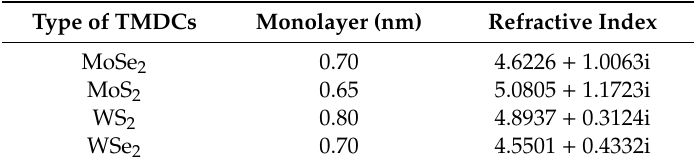
Table 1. The thickness of monolayer and refractive index of transition metal dichalcogenides (TMDCs) at λ = 632.8